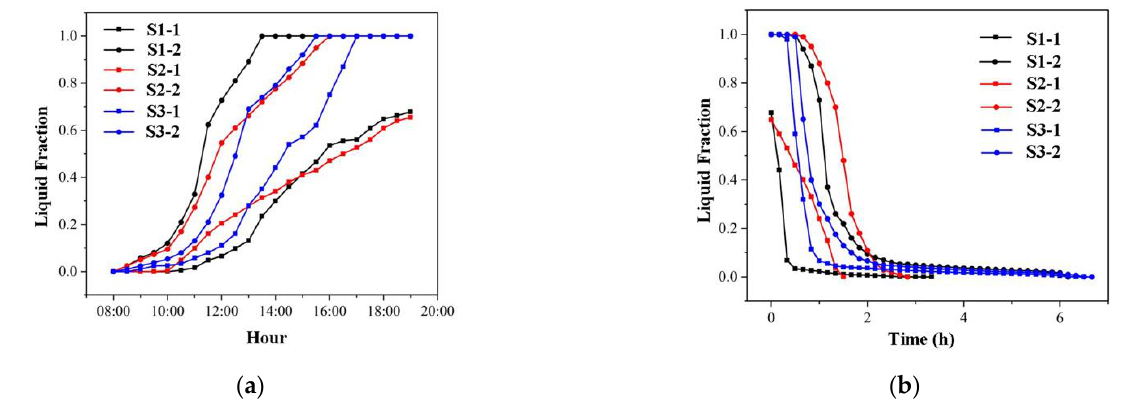
Figure 8. Liquid fraction in the cascade units of S1 – S3: ( a ) heat storage process; ( b ) heat release pro- cess.